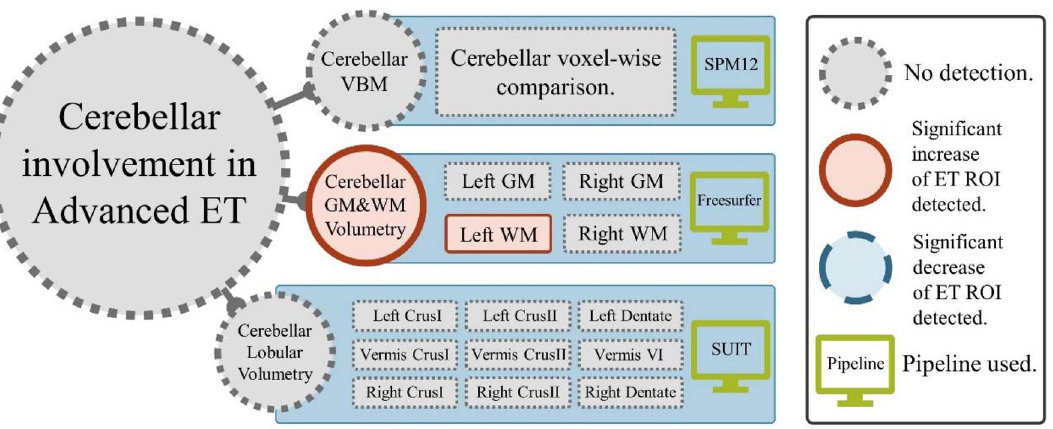
Figure 1. Results of consensus based hypothesis testing: (1) VBM with SPM12; (2) Cerebellar GM & WM volumetry with Freesurfer; (3) Cerebellar lobular volumetry with SUIT. Gray circles and rectangles with darker dotted outlines represent no detection, red circles and rectangles with solid outlines represent significant increase of ET ROIs, blue circles and rectangles with dashed outlines represent significant negative effects of ET group (No such result discovered in our